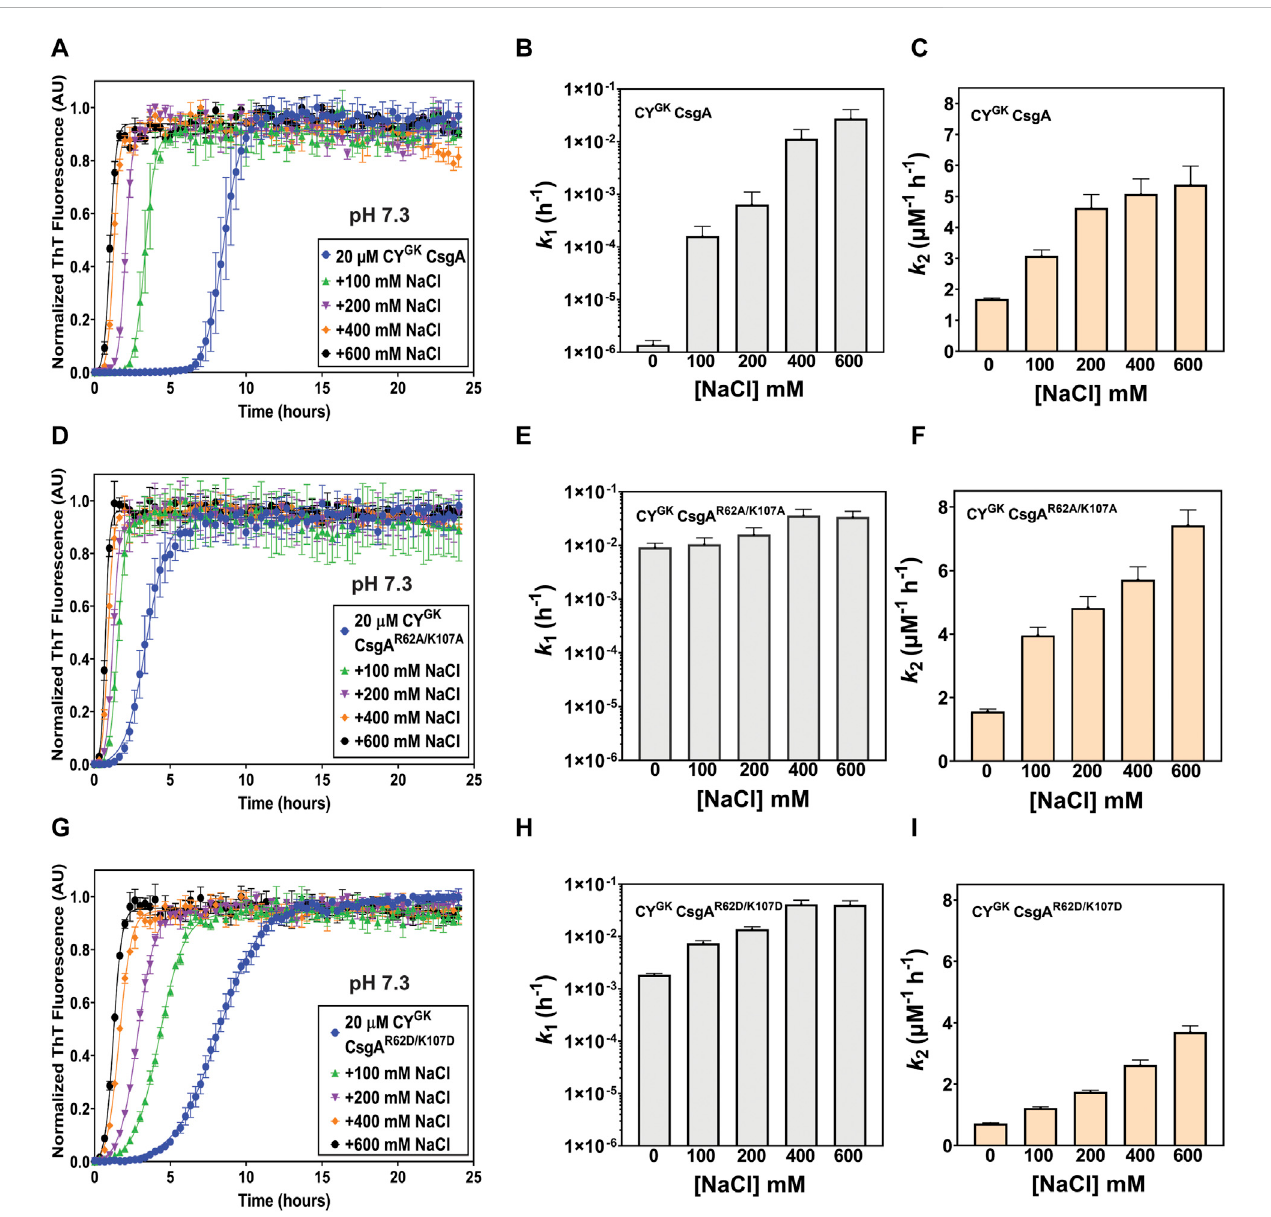
FIGURE 2 Gatekeeping function is sensitive to salt-mediated charge screening. Analysis of aggregation kinetics of CY GK CsgA, CY GK CsgA R62A/K107A , and CY GK CsgA R62D/K107D at 37 ° C, pH 7.3 in presence of increasing NaCl concentrations. (A) ThT fl uorescence assay of CY GK CsgA. (B) Nucleation rates k 1 of amyloidosis (log scale) of CY GK CsgA. (C) Growth rates k 2 of amyloid fi ber propagation (linear scale) of CY GK CsgA. (D) ThT fl uorescence assay of CY GK CsgA R62A/K107A . (E) Nucleation rates